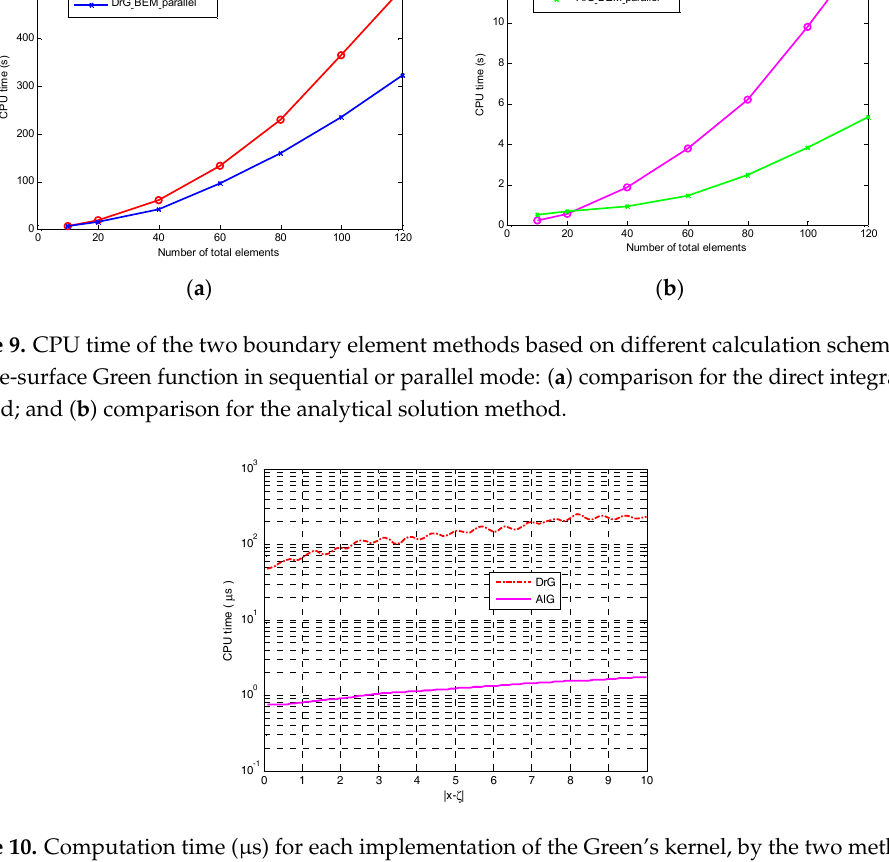
Figure 10. Computation time ( μ s) for each implementation of the Green’s kernel, by the two methods, respectively, as a function of point distance | x − ξ |. The figure is obtained based on averaged CPU time of 1 million evaluations of the two codes, respectively, for every input of the wave period ω .